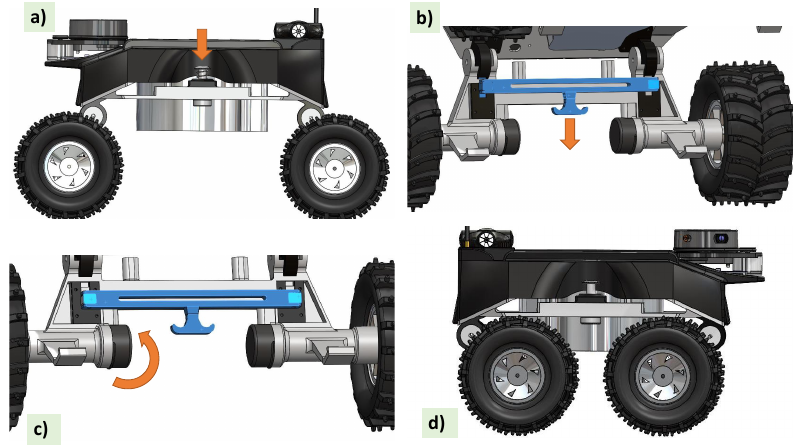
Figure 2. Steps of the reconfiguration. ( a ) Push button pressing to open the provision to insert and hold the pin ( b ) Pulling the lock open when triggering the pull lever ( c ) Adjusting the wheel assemblies ( d ) New wheel assembly configuration